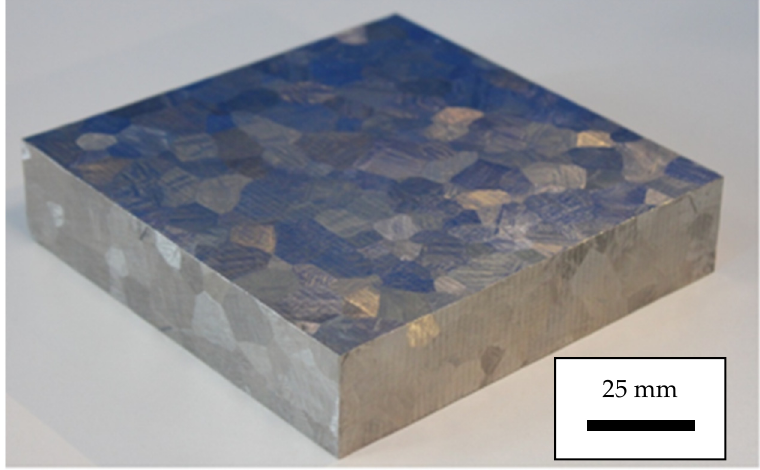
Figure 1. Grain structure revealed at the surface of a vacuum heat-treated block of LG685. Two specimen geometries were adopted for various forms of static and cyclic me- chanical testing, a plain cylindrical specimen and a flat plate geometry, illustrated in Figures 2 and 3 respectively.